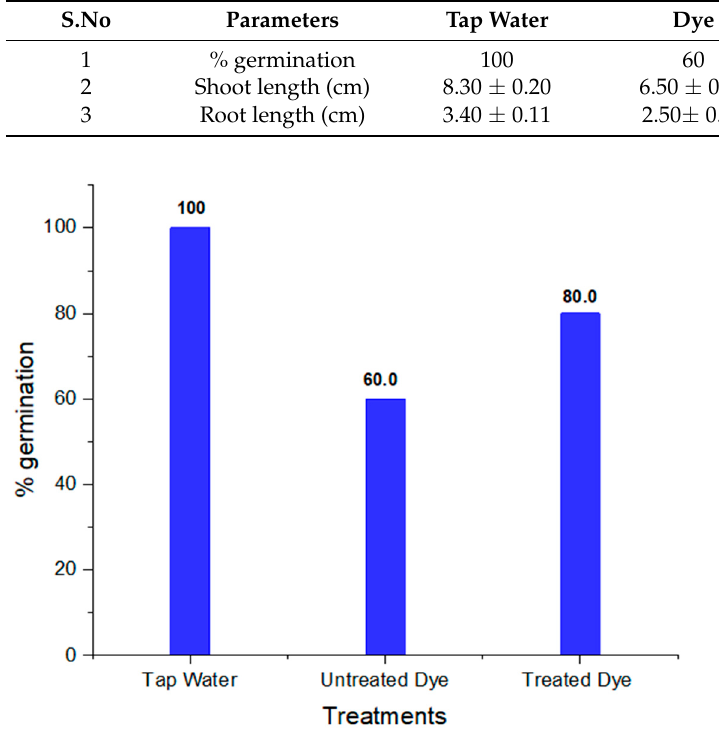
Figure 14. Percentage germination of Vigna radiata seeds in tap water and in untreated and treated orange II dye.